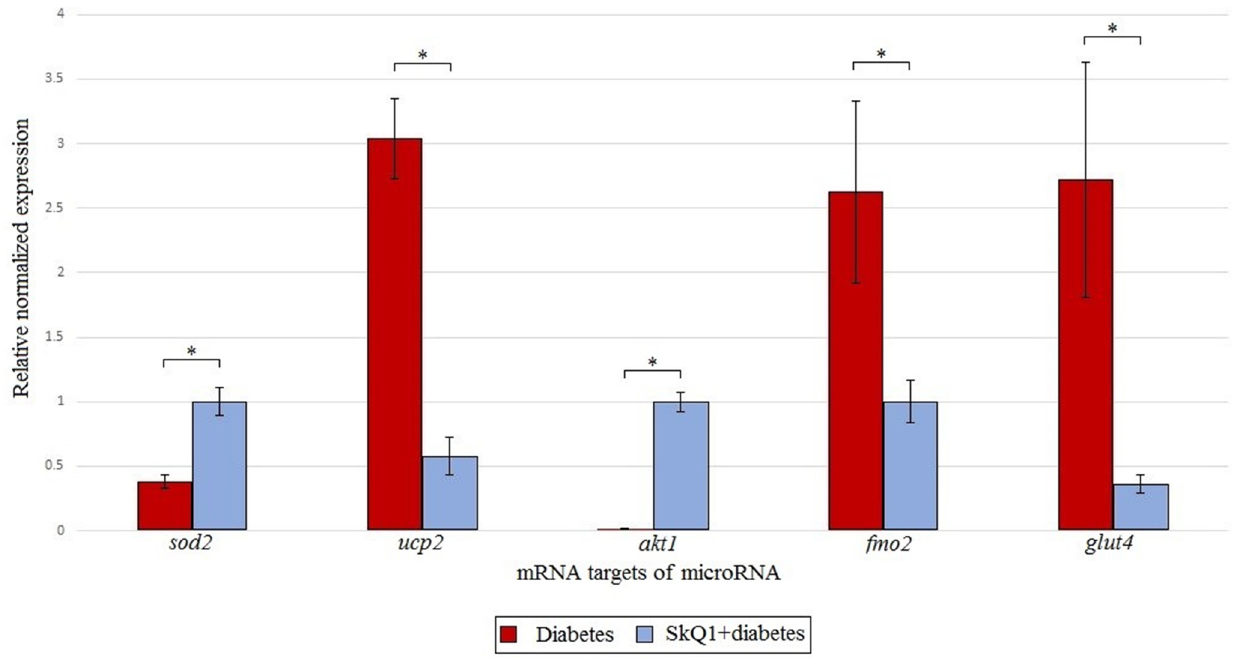
Figure 5. Expression analysis of mRNA targets of microRNAs after pre-therapy with SkQ1 (* p ≤ 0.05).